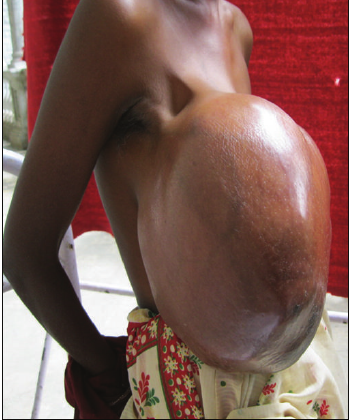
Figure 2: Lateral view of the tumour.